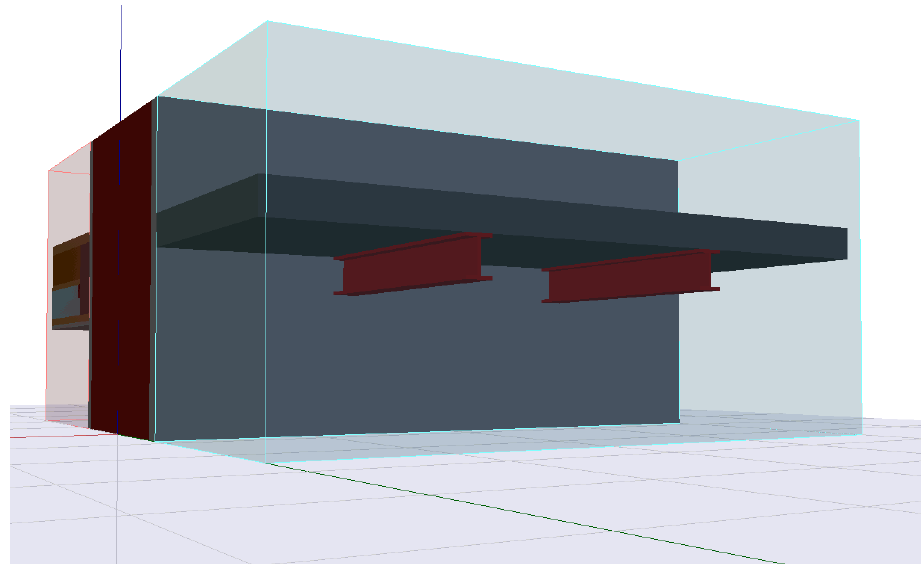
Figure 14. Geometric model—solid view from the outside with boundary condition solids. The materials are the same as for Figure 13.